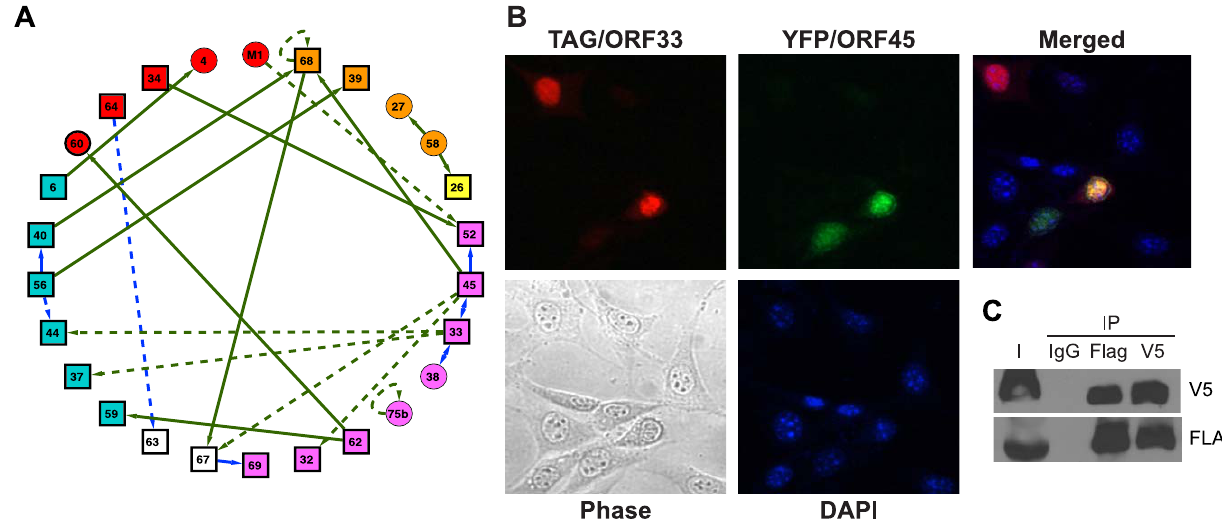
Figure 2. The network of interactions between MHV-68 proteins. (A) The MHV-68 intra-viral protein interaction network. Rectangles designate viral proteins essential for MHV-68 lytic replication; circles, nonessential MHV-68 proteins. Colors indicate protein functions (blue, DNA replication complex; red, regulatory proteins; orange, envelope proteins; purple, capsid; magenta, assembly or egress; white, unknown function). Arrows point from baits to preys. Interactions confirmed by co-immunoprecipitation (co-IP) are shown as solid lines, whereas those found only by Y2H are shown as dashed lines. Green lines indicate novel interactions found in this study; blue lines represent interactions detected between homologues in other data sets (see Table S1 for references). (B) ORF33 and ORF45 co-localize in the nucleus. Expression plasmids encoding FLAG epitope-tagged ORF33 and YFP-tagged ORF45 were co-transfected into NIH 3T3 cells. FLAG-ORF33 was detected by IFA with anti-FLAG-M2 primary antibody and Alexa Fluor 594-conjugated anti-mouse IgG antibodies. Panel 1 shows FLAG epitope-tagged ORF33 (red); panel 2, YFP-ORF45 (green); panel 3, merged image; panel 4, phase contrast image of same field; panel 5: DAPI-stained nuclei. (C) Co-IP of ORF33 and ORF45. FLAG epitope- tagged ORF33 and V5 epitope-tagged ORF45 were co-expressed in 293T cells, immunoprecipitated with either control IgG, anti-FLAG M2 or anti-V5 antibodies, and subjected to western blotting with anti-V5 antibody (upper panel) and anti-FLAG (bottom panel). I indicate input.